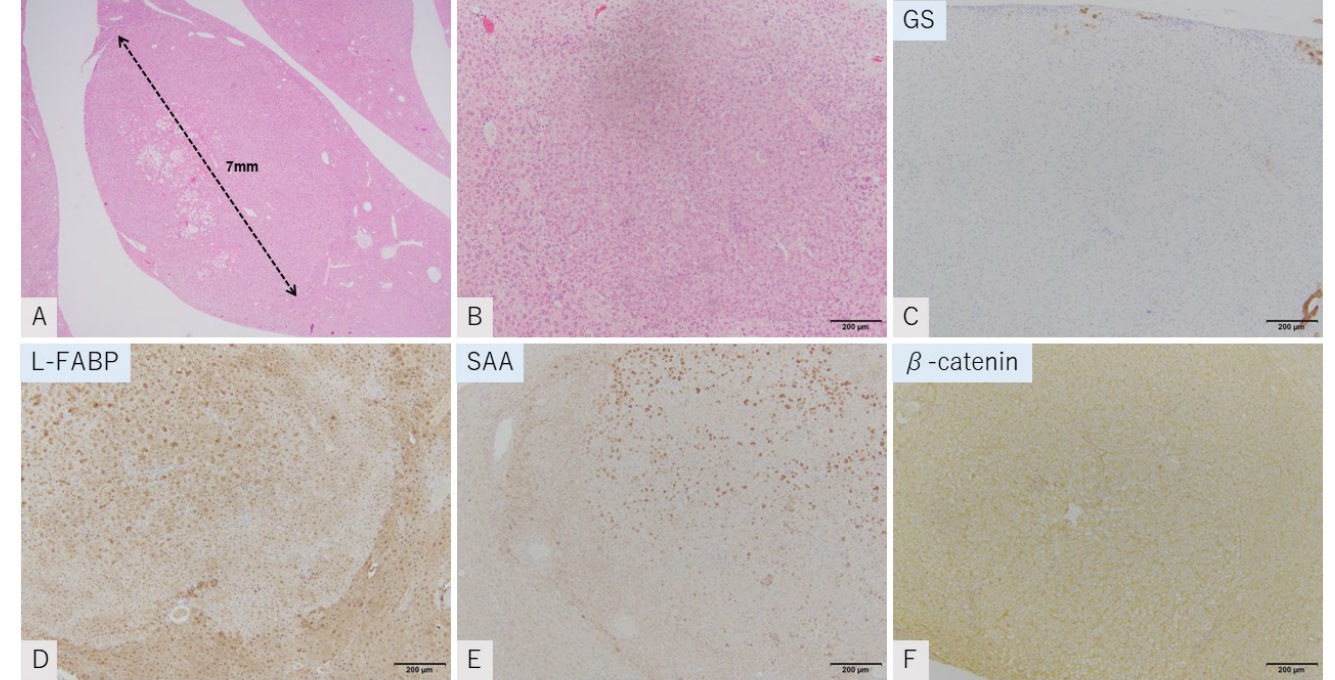
Figure 4. GS-negative tumor mimic of both HNF1 a-inactivated HCA and inflammatory HCA (tumor 1). HE staining ( A , B ). Immunostaining of GS ( C ), L-FABP ( D ), SAA ( E ), and b-catenin ( F ). Tumor shows a trabecular pattern of hepatocytes with mild vacuolation. Sinusoidal dilatation is observed. There is sparse aggregation of inflammatory cells. No capsule is observed. GS: negative, L-FABP: attenuated, SAA: strong positive staining was observed in parts, b-catenin: membranous staining. Tumor diameter is 7 mm in ( A ) (scale: B – F , 20 μm).